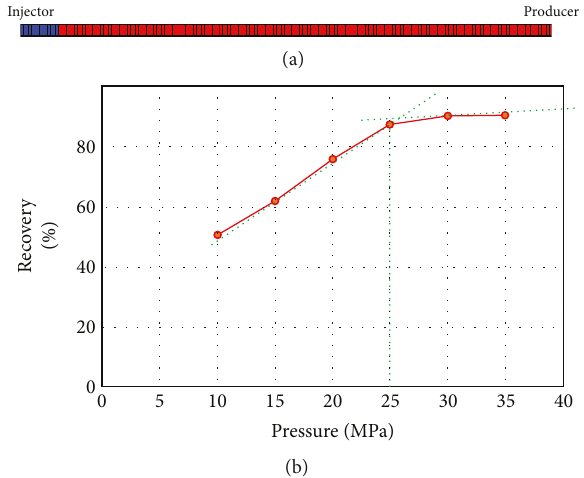
Figure 2: (a, b) Numerical simulation method forecasting MMP